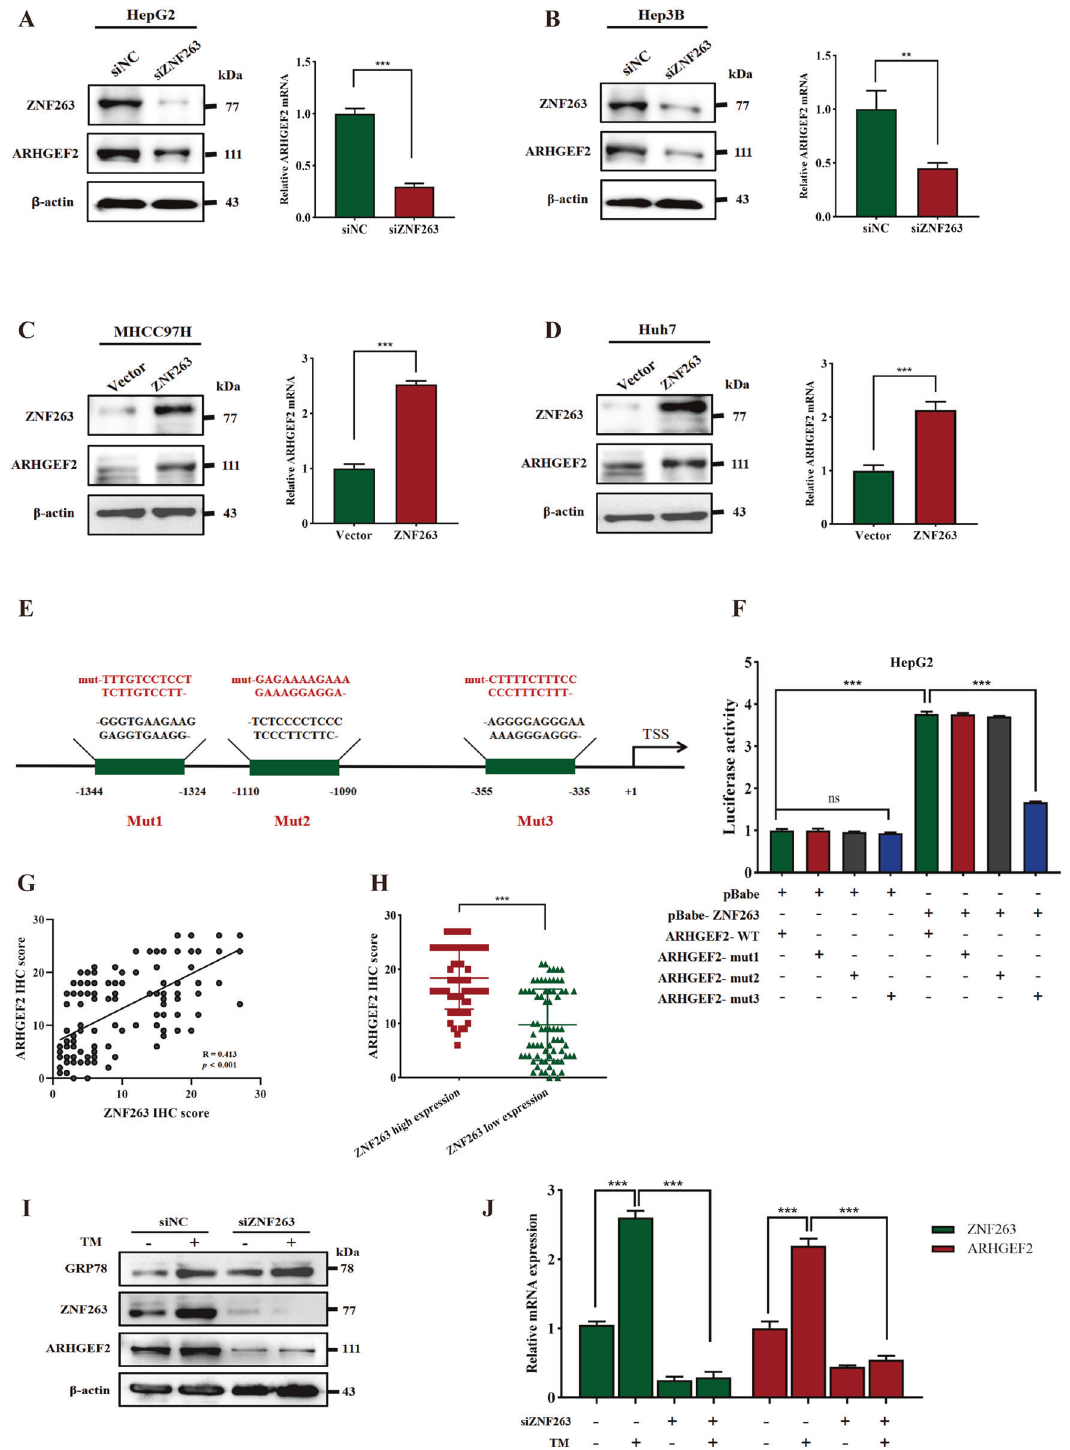
Fig. 2 ER stress upregulated ARHGEF2 expression through the activation of ZNF263. A , B After knockdown of ZNF263 in the HepG2 cells ( A ) and the Hep3B cells ( B ), the levels of the ARHGEF2 protein and mRNA were detected using western blot and qRT-PCR. C , D After overexpression of ZNF263 in the MHCC97H cells ( C ) and the Huh7 cells ( D ), the levels of the ARHGEF2 protein and mRNA were detected using western blot and qRT-PCR. E Schematic representation of the putative three mutated (mut) ZNF263-binding sites in the promoter of the human ARHGEF2 gene from the Jaspar transcription pro fi le database (http://jaspar.genereg.net). F Cells were co-transfected with ARHGEF2- luc, ARHGEF2-mut-R1, ARHGEF2-mut-R2, or ARHGEF2-mut-R3 together with pBabe-ZNF263 or pBabe. Relative luciferase activity was detected 24 h after transfection. G IHC was performed on liver cancer and adjacent tissues of 138 patients, and the correlation between ARHGEF2 and ZNF263 was analyzed. H IHC staining index of ARHGEF2 in the ZNF263 high/low group. I , J Western blot ( I ) and qRT-PCR ( J ) was used to detect whether TM induced the changes of the ZNF263 and ARHGEF2 level after ZNF263 knocked down. Cell Death and Disease (2022)